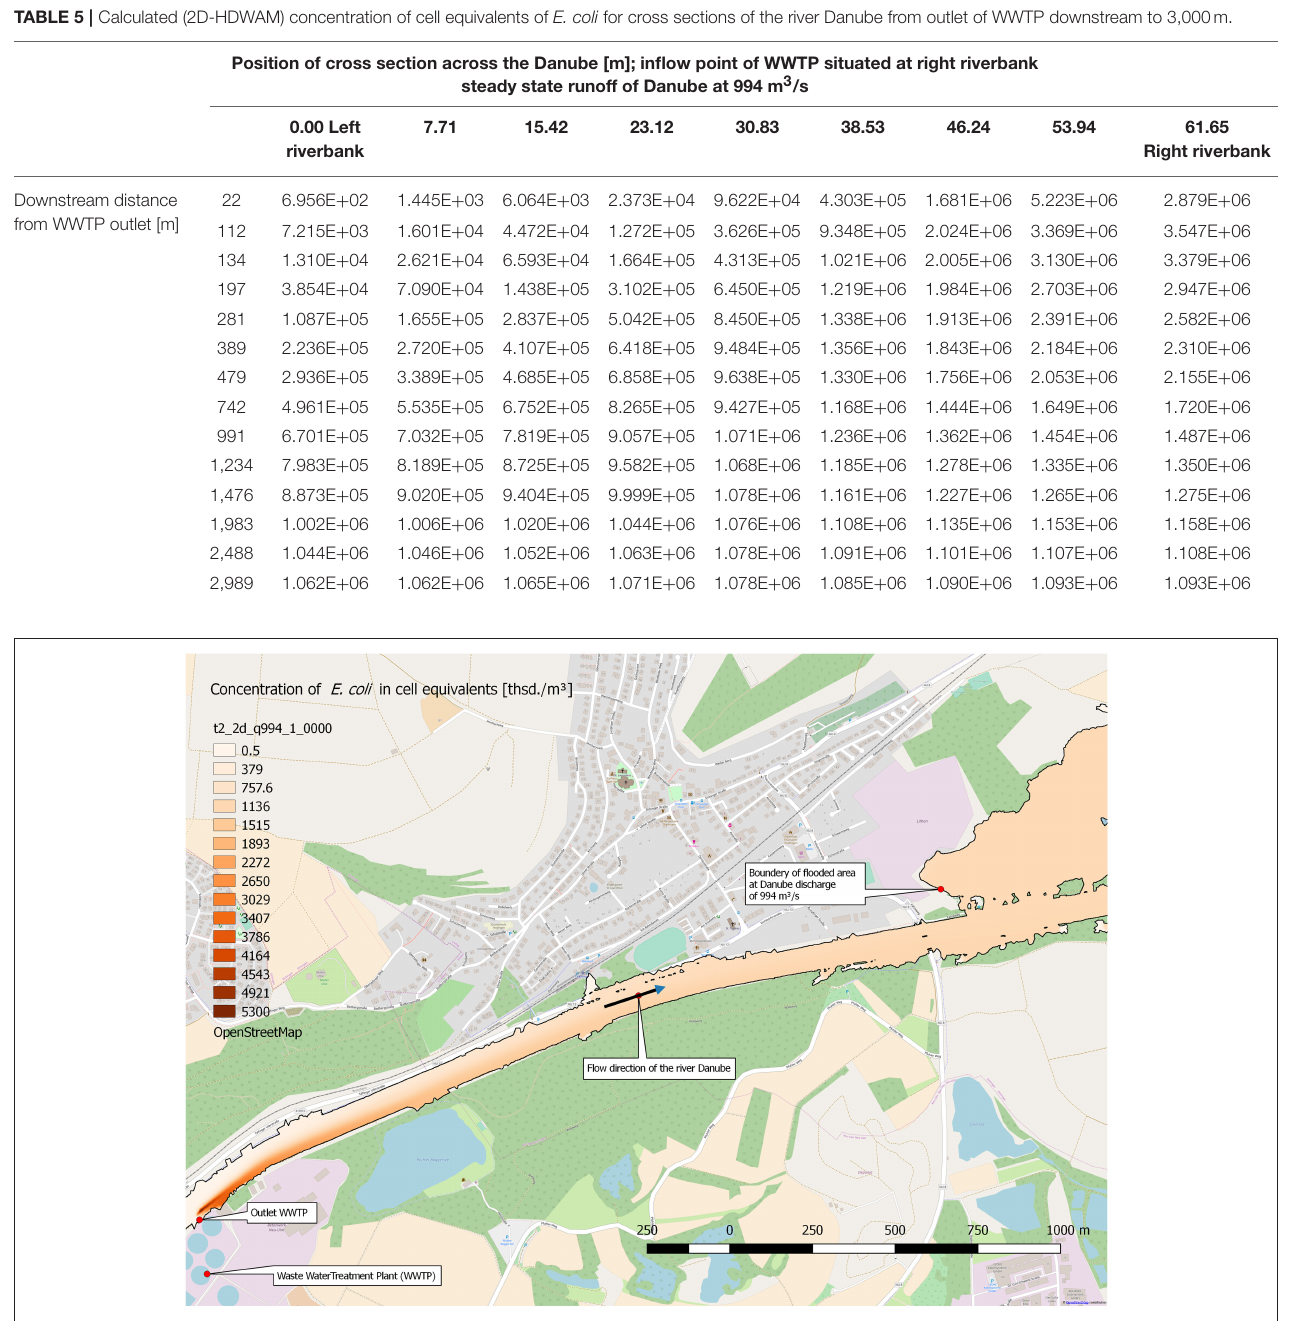
FIGURE 7 | Distribution of calculated (2D-HDWAM) concentration of E. coli in the river Danube downstream of the WWTP, 9.20 × 10 8 cell equivalents/m 3 in outlet of WWTP, discharge of Danube at 994 m 3 /s (HQ20), interpolated results.